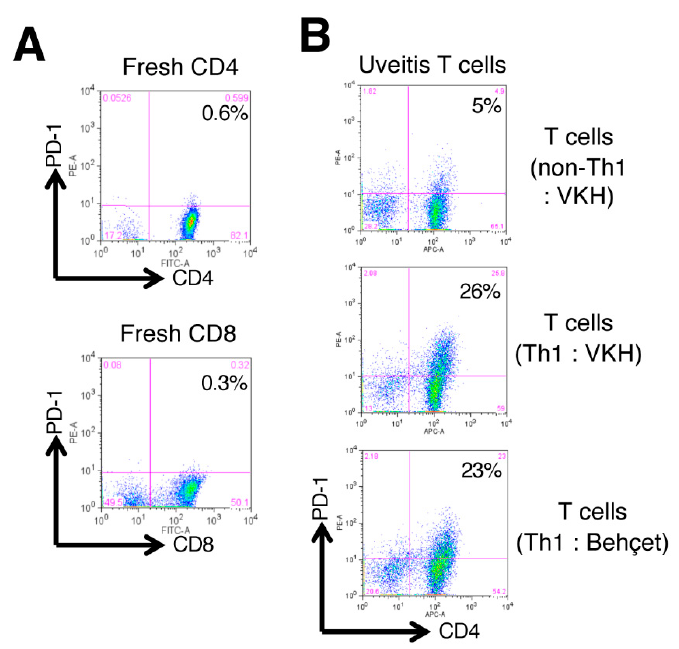
Figure 4. Expression of PD-1 on T cells from uveitis patients. ( A ) Expression of PD-1 (receptor for B7-H1 / B7-DC) on T cells from PBMC of a healthy donor. Upper histogram: fresh naïve CD4 + T cells; lower histogram: fresh naïve CD8 + T cells by FACS analysis. ( B ) Expression of PD-1 on non-Th1-type CD4 + T cells from a VKH uveitis patient, and Th1-type CD4 + T cells from uveitis patients with VKH disease or Behçet’s disease. Numbers in the histograms indicate the percentage of cells double-positive for CD4 / CD8 and